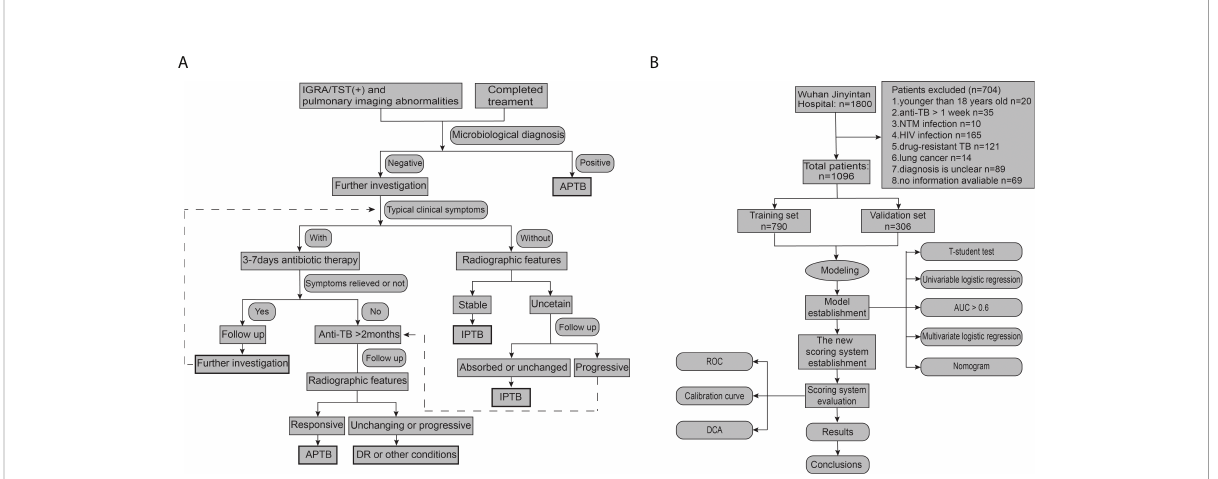
FIGURE 1 Flowchart of participant selection and the performance of the steps (A) ; Flowchart of the diagnostic criteria for APTB and IPTB (B) . APTB, active pulmonary tuberculosis; IPTB, inactive pulmonary tuberculosis; NTM, non-tuberculous mycobacteria; DCA, decision curve analysis; ROC, receiver operating characteristic. AUC, area under the curve; DR, drug